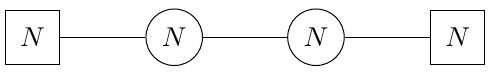
Figure 15 . Homogeneous U( N ) × U( N )